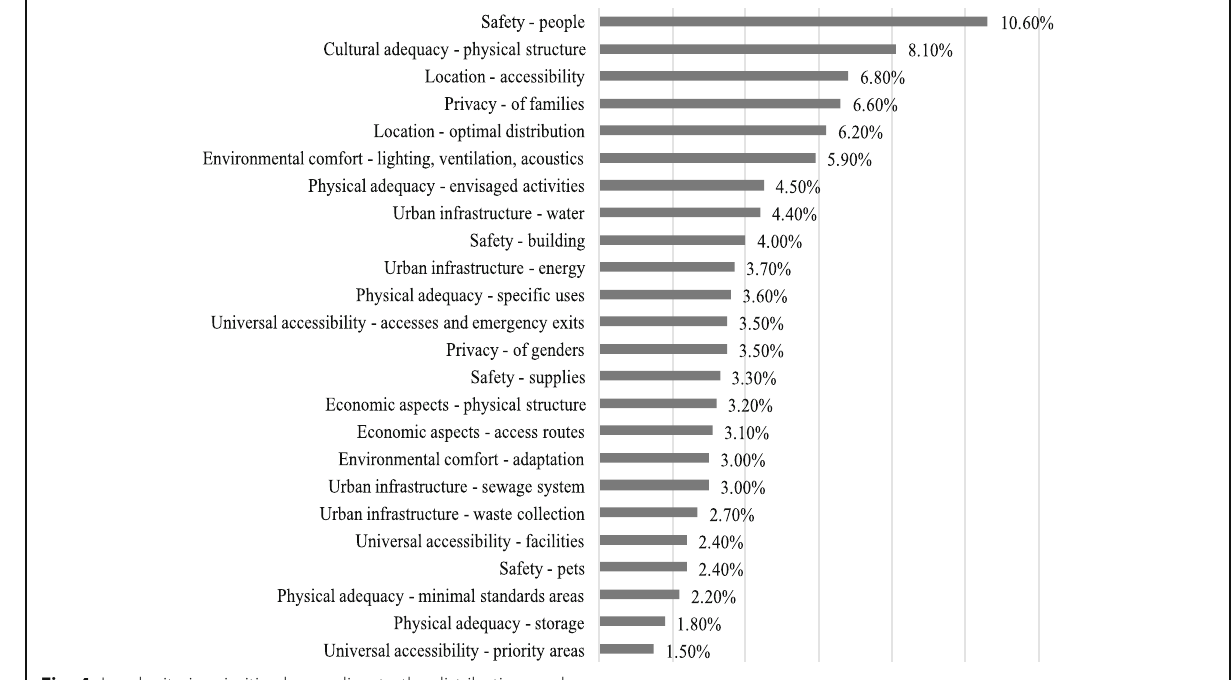
Fig. 4. Local criteria prioritized according to the distributive